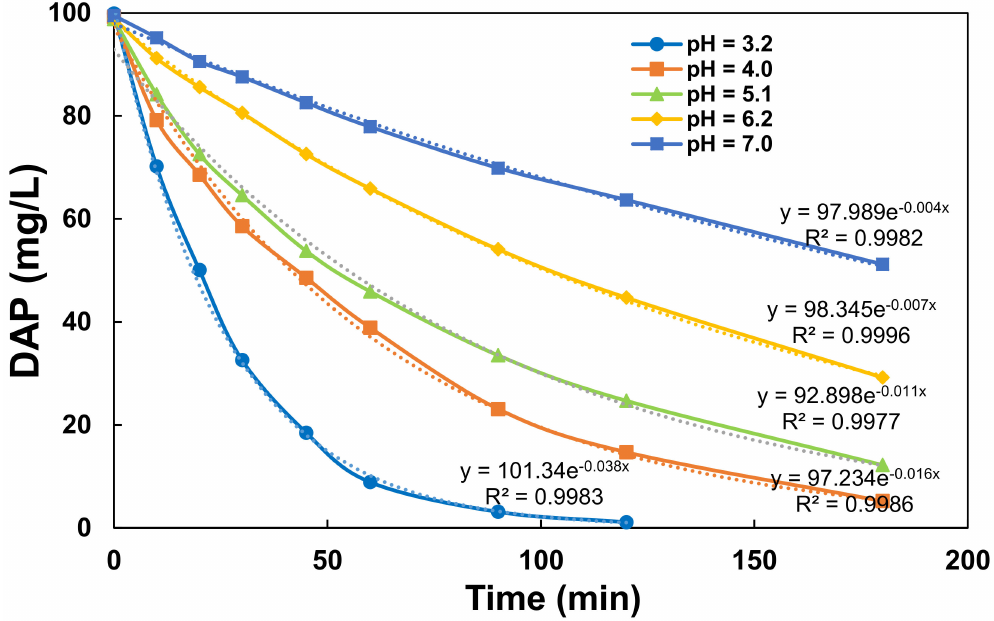
Figure 2. Influence of the initial pH on the DAP degradation kinetics during the Fenton process (H 2 O 2 /Fe 2+ ). Experimental conditions: [DAP] 0 = 100 mg/L; [H 2 O 2 ] = 1000 mg/L; [Fe 2+ ] = 50 mg/L; pH =